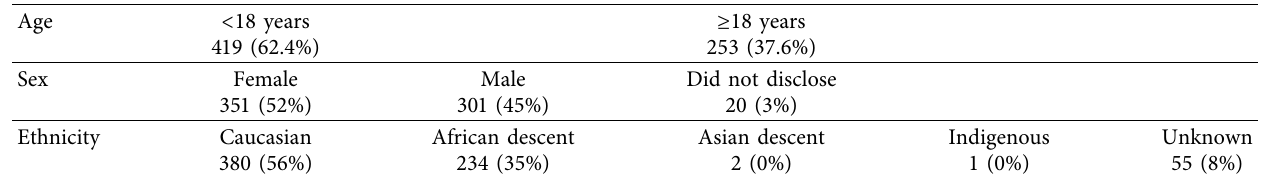
Table 1: Sample description by age, sex, and ethnicity.